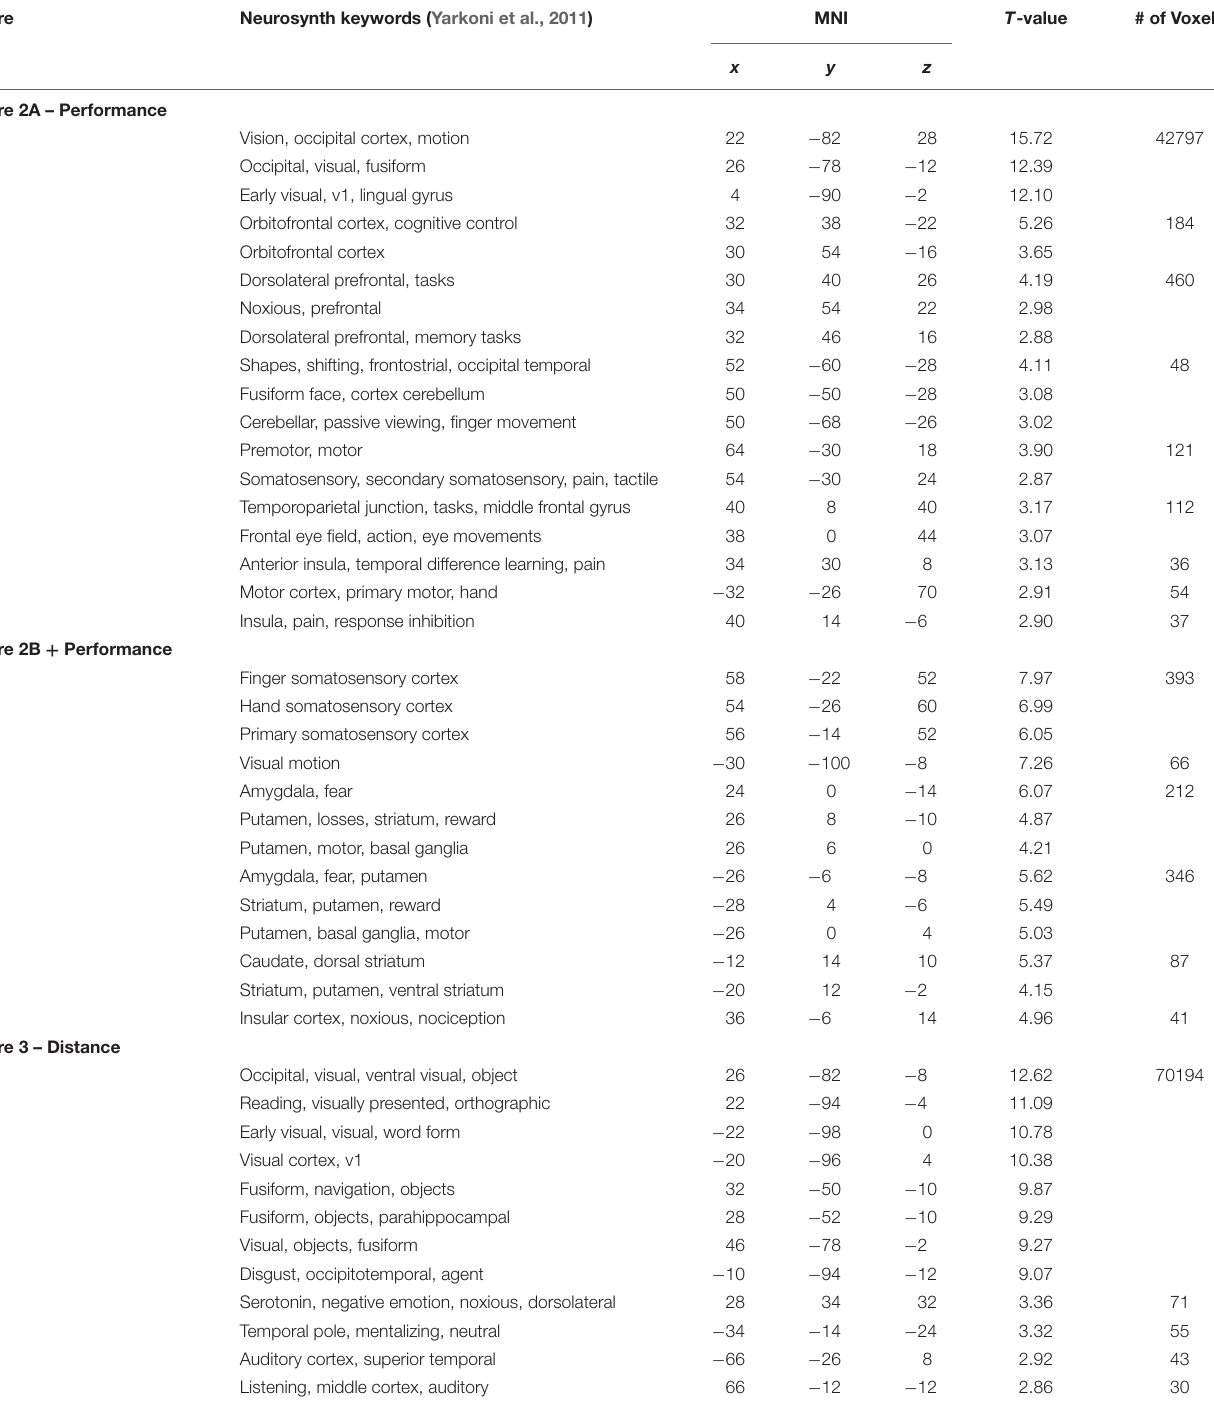
TABLE 1 | MNI coordinates for selected cluster maxima ( > 8 mm apart) of brain activity in presented figures. Figure Neurosynth keywords (Yarkoni et al., 2011) MNI